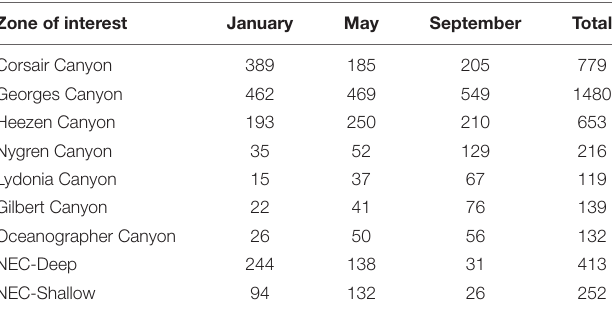
TABLE 4 | Number of tracks originating from each of the 9 zones of interest and ending at 15 endpoints offshore of Corsair Canyon (northwest